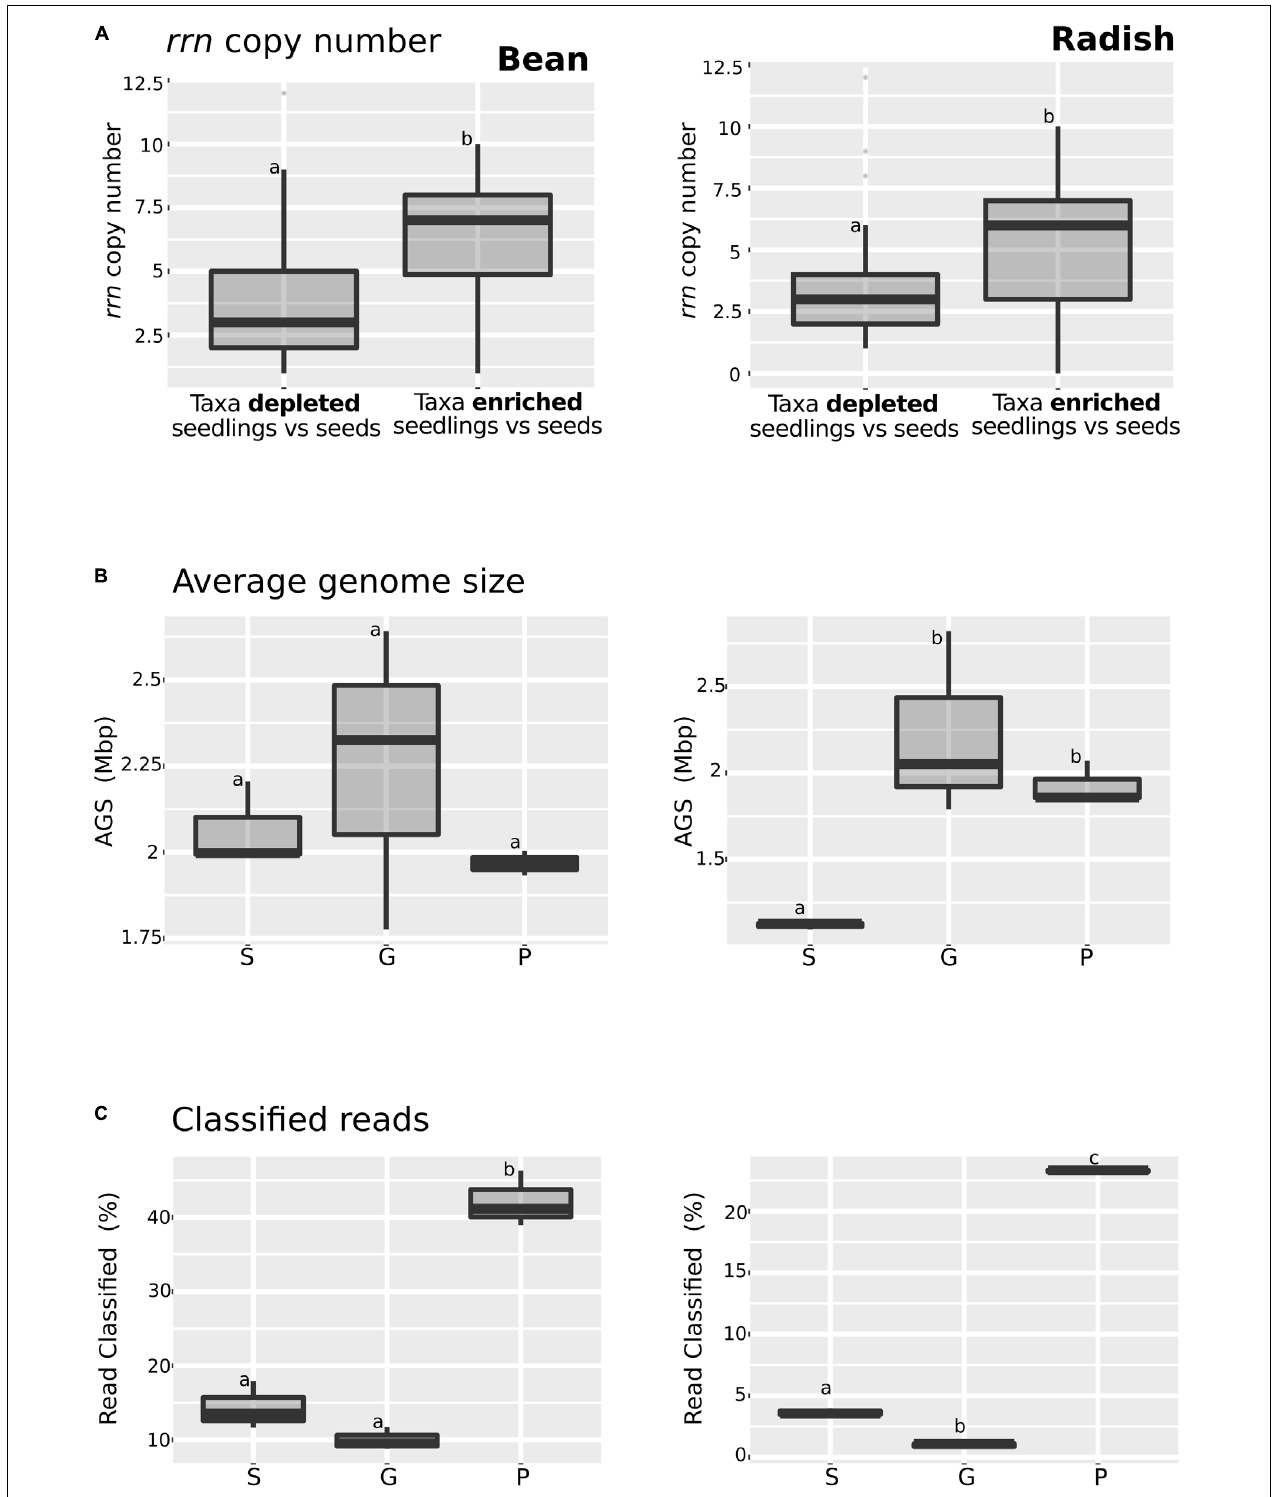
FIGURE 3 | Analysis of some of the key copiotrophic characteristics in metagenome datasets. (A) rrn copy number of taxa that are significantly more or less abundant in seedling samples in comparison to seeds (DeSeq2; log2 FC > 3, P < 0.01). (B) Average genome size and (C) Proportion of classified reads among the samples investigated. Letters indicate differences between individual means assessed with one factor ANOVA with post hoc Tukey HSD ( P < 0.05). The left part of the panel shows bean samples and the right part radish samples. S, seeds; G, germinating seeds, and P, Seedlings.